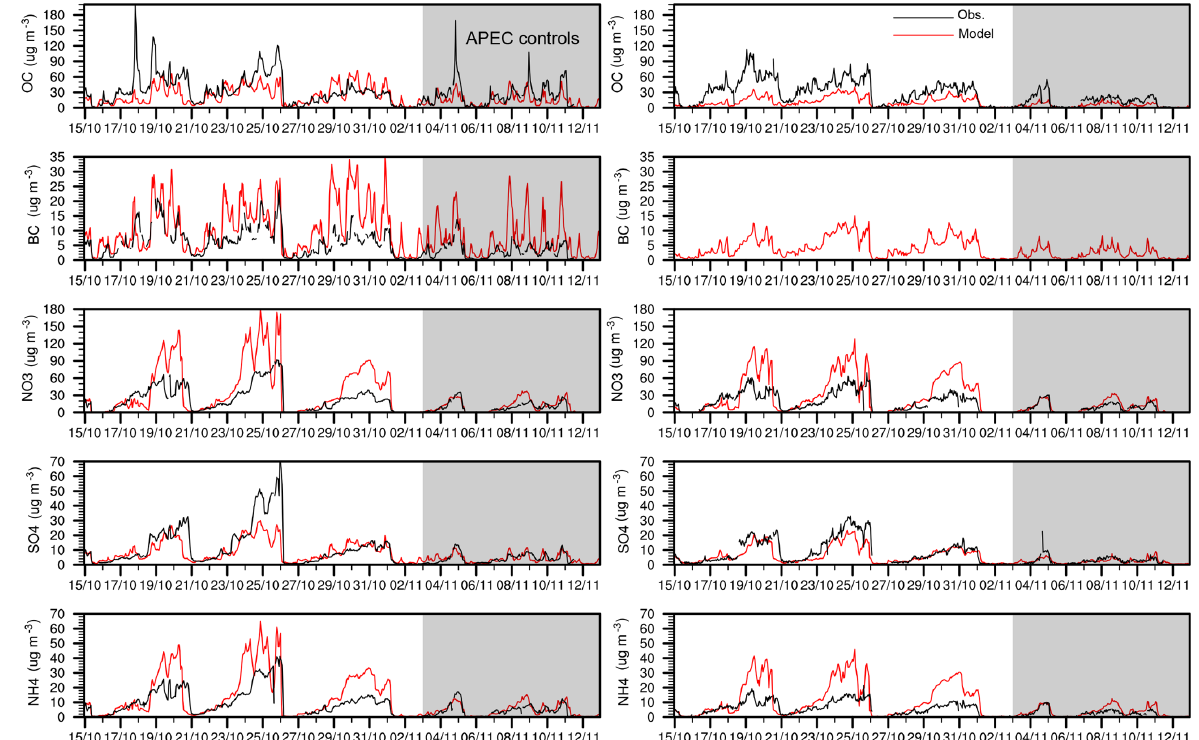
Figure 5. Measured and simulated aerosol components at the surface (left) and 260m (right) on IAP tower in Beijing. Model values are with baseline emissions at all times, including during the APEC period